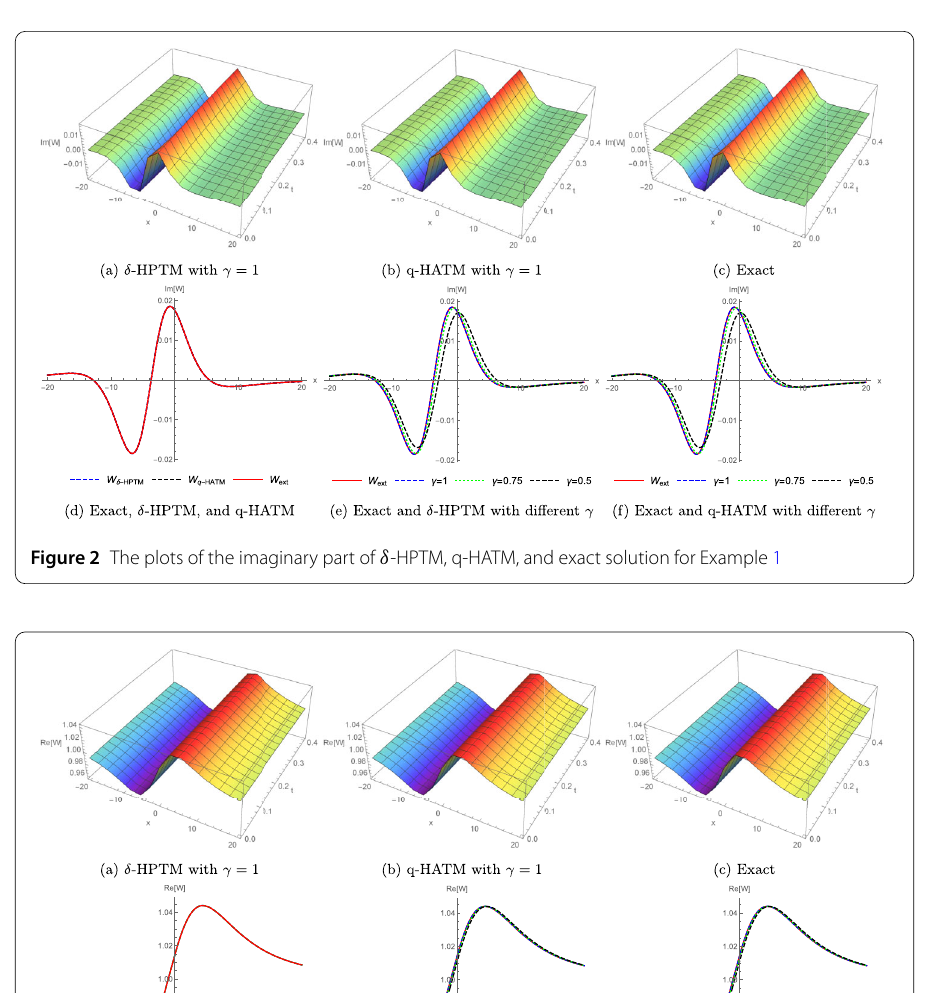
soliton-like solutions, whereas Figs. 5, 6 represent the periodic wave solutions of the gpZK equation. The dynamics of the solution profile can obviously be noted and justify why gpZK should be examined to understand the effects in real-life